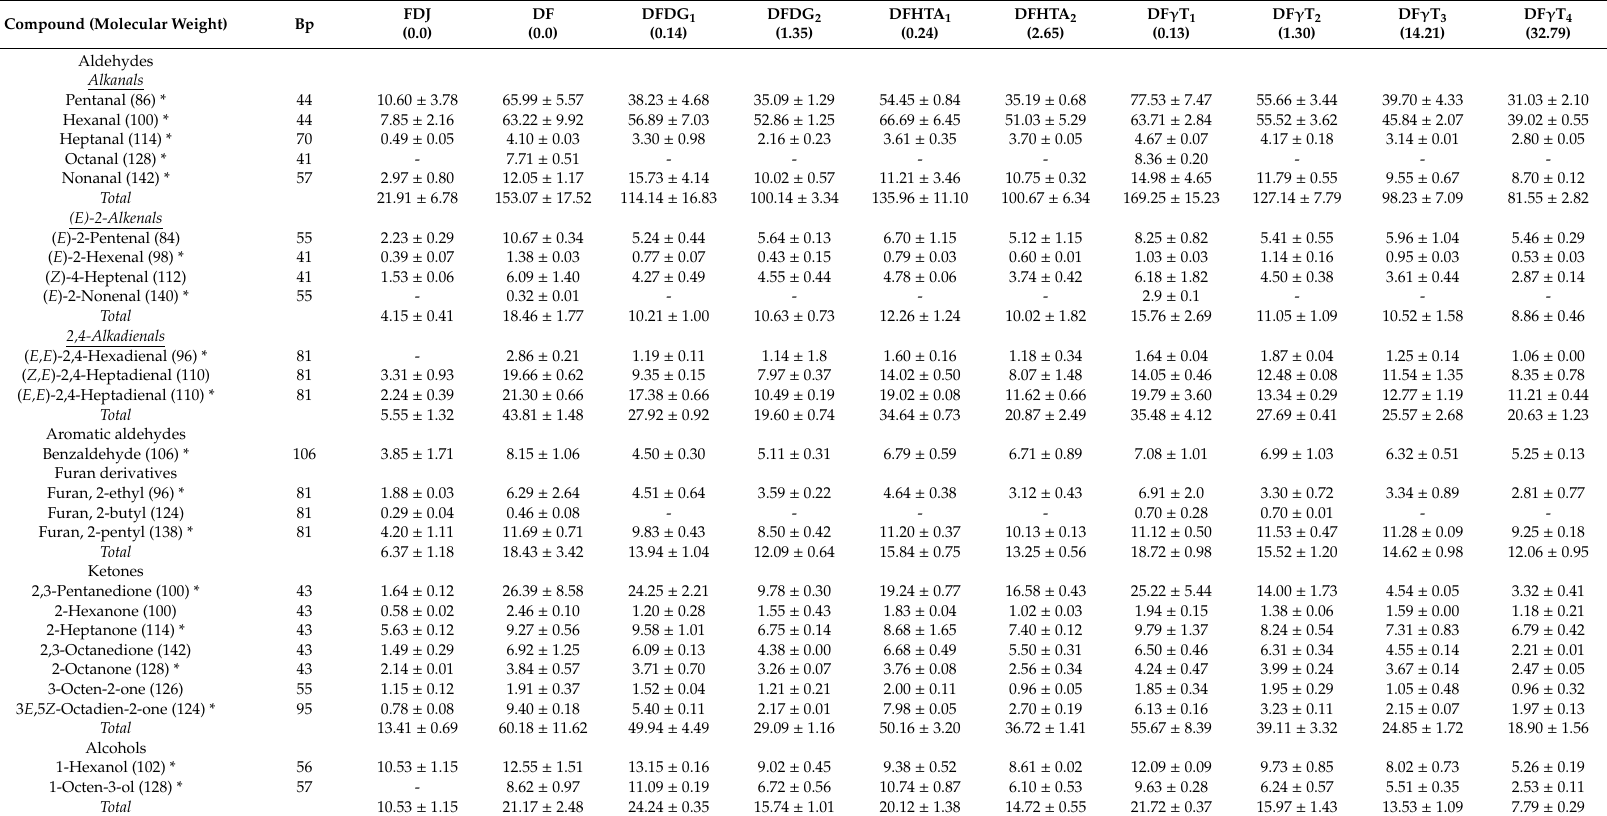
Table 3. Abundances of some volatile oxidation markers extracted by SPME from the headspace of the mixture of digestive juices and virgin flaxseed oil FDJ, from the digestate of this oil DF, and from the digestates of the samples enriched in dodecyl gallate, hydroxytyrosol acetate, and gamma-tocopherol (DF, DFDG 1 , DFDG 2 , each oil sample before digestion given in mmol / mol (AG + FA) O . Data are expressed as area counts of the mass spectra base peak (Bp) of each compound multiplied by 10 − 6 , obtained as the average of two determinations, together with their standard